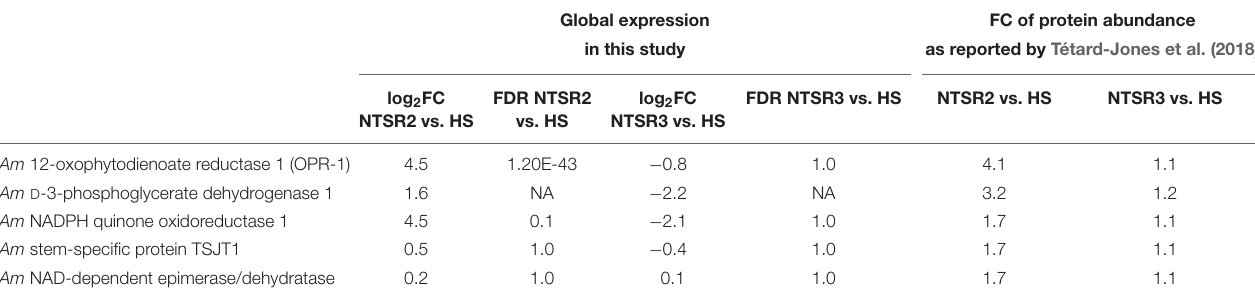
The table includes the protein amount in each population in order to compare the transcriptome with the proteomic data. HS, herbicide-sensitive population; NTSR2, derived from HS and selected for resistance to pendimethalin; NTSR3, derived from HS and selected for resistance to fenoxaprop-P-ethyl; FC, fold change; FDR, false discovery rate; Am, Alopecurus